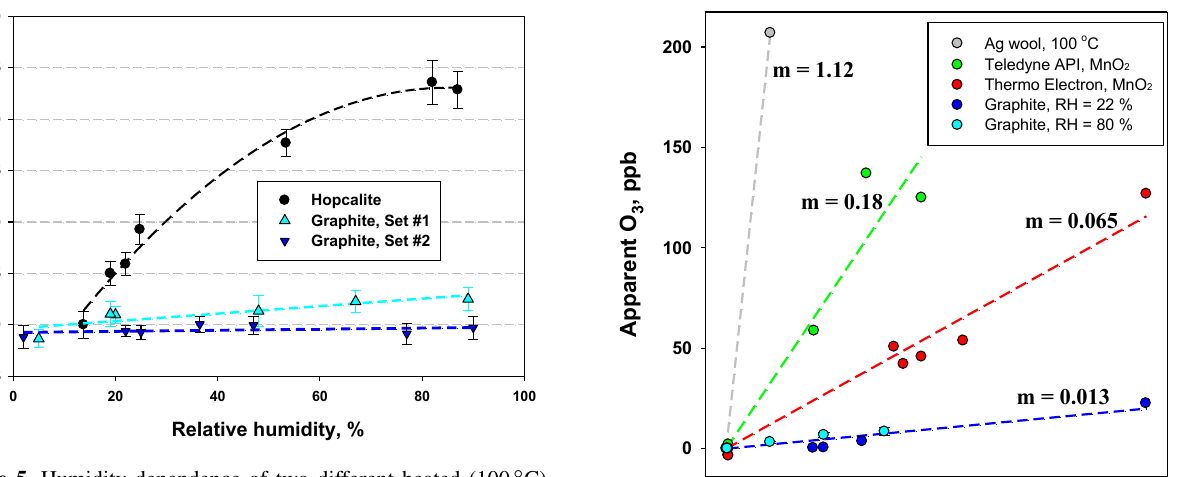
Figure 5. Humidity dependence of two different heated (100 ◦ C) graphite scrubbers as well as that of a Hopcalite scrubber. The ozone analyzer was a 2B Technologies Model 202 single-beam in- strument. Data points were 2min averages obtained 15min after a change in relative humidity. Error bars are 1 σ of the 2min average. The experiment was conducted at 20 ◦ C. Note that the step changes in humidity were not as large as those shown in Fig. 4, thus leading to smaller observed artifact signals for the Hopcalite scrubber.